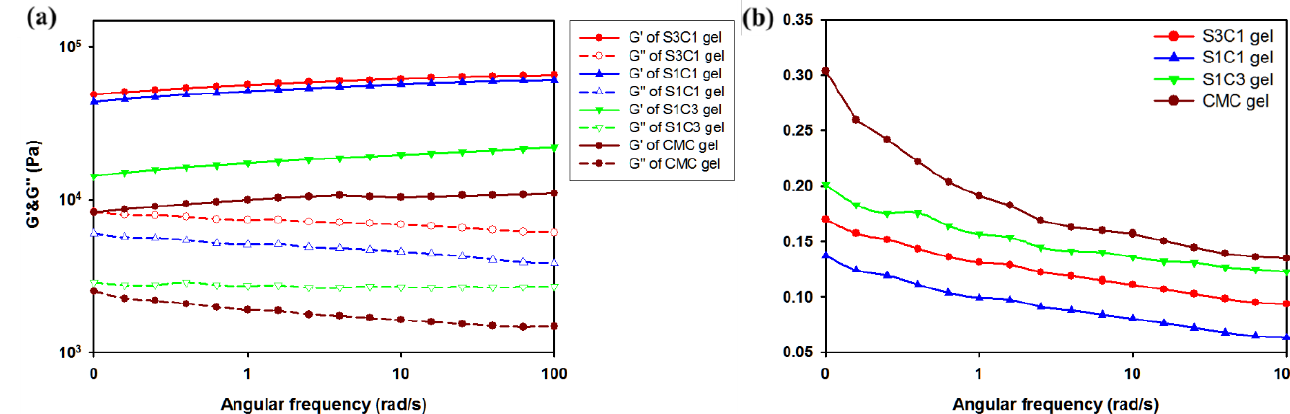
Figure 5. Rheological observations from the oscillation angular frequency sweep test: ( a ) Storage modulus (G′, filled symbols) and loss modulus (G″, empty symbols) of hydrogels; ( b ) The loss tangent (tan δ) of hydrogels.